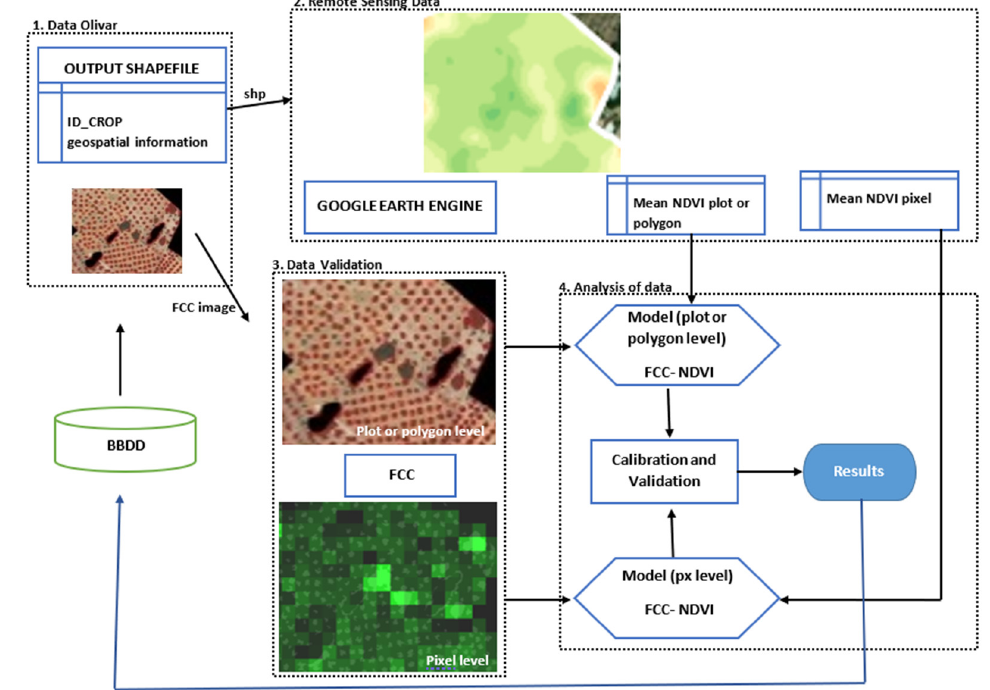
Figure 7. General methodology for estimating FCC in olive groves.